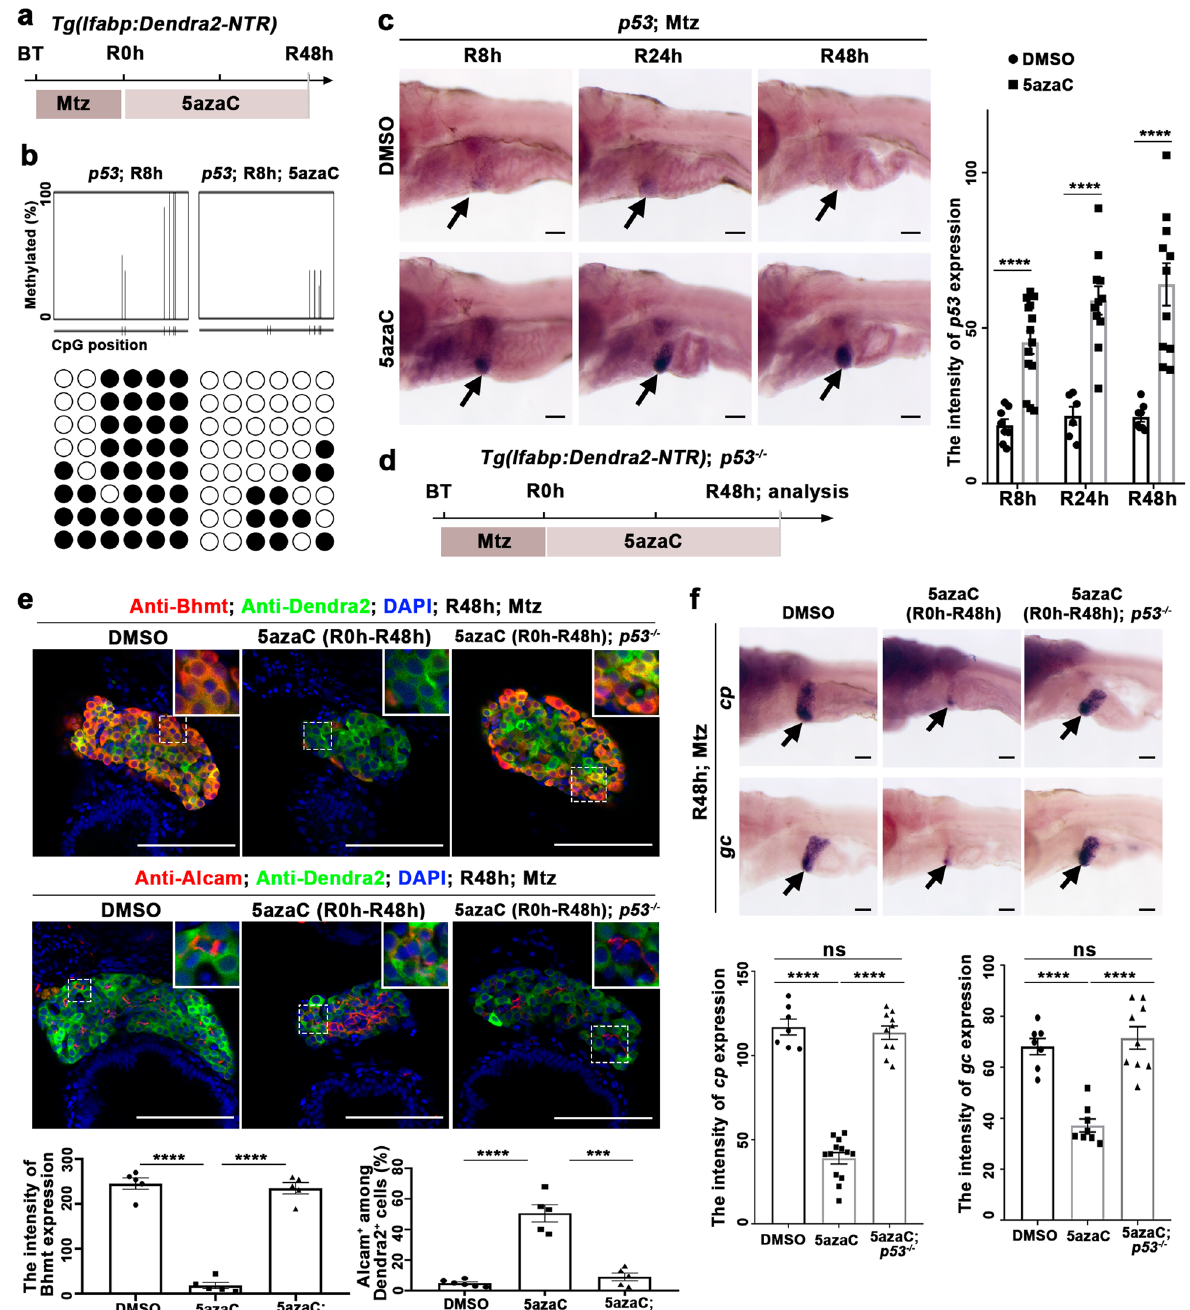
Fig. 5 Late DNA methylation inhibition represses BPPC redifferentiation through p53 activation. a Experimental scheme illustrating the 5azaC and Mtz treatment and analysis from R8h to R48h. b Bisul fi te sequencing analysis of DNA methylation at the p53 locus in DNA isolated from DMSO and 5azaC-treated livers. c WISH images showing the expression of p53 from R8h to R48h during liver regeneration after late DNA methylation inhibition. Quanti fi cation of the intensity of p53 expression in liver regions from R8h to R48h. d Experimental scheme illustrating the 5azaC and Mtz treatment and analysis at R48h in p53 mutant and WT. e Single-optical section images showing the expressions of hepatocyte marker Bhmt and BECs marker Alcam at R48h. Quanti fi cation of the intensity of Bhmt expression and the percentage of Alcam + among Dendra2 + cells in liver regions at R48h. f WISH images showing the expressions of cp and gc at R48h after 5azaC treatment in control and p53 mutant after late DNA methylation inhibition. Quanti fi cation of the intensity of cp and gc expressions in liver regions at R48h. Note that the downregulation of cp and gc expressions was recovered in p53 mutant after 5azaC treatment. Asterisks indicate statistical signi fi cance: *** P < 0.001; **** P < 0.0001 using t -tests analysis when compared to control. Scale bars: 100 µm; error bars, ±SEM. DAPI 4 ′ ,6-diamidino-2- phenylindole, BT before treatment, ns no signi fi cant difference, R regeneration time after the withdrawal of